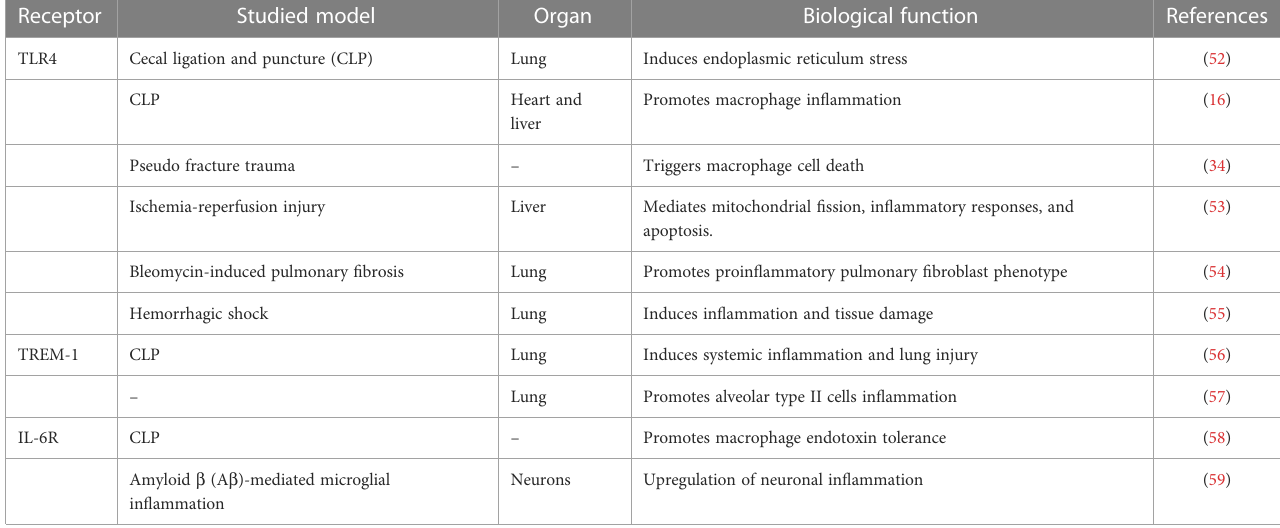
TABLE 1 eCIRP-related receptors and their biological functions. Receptor Studied model